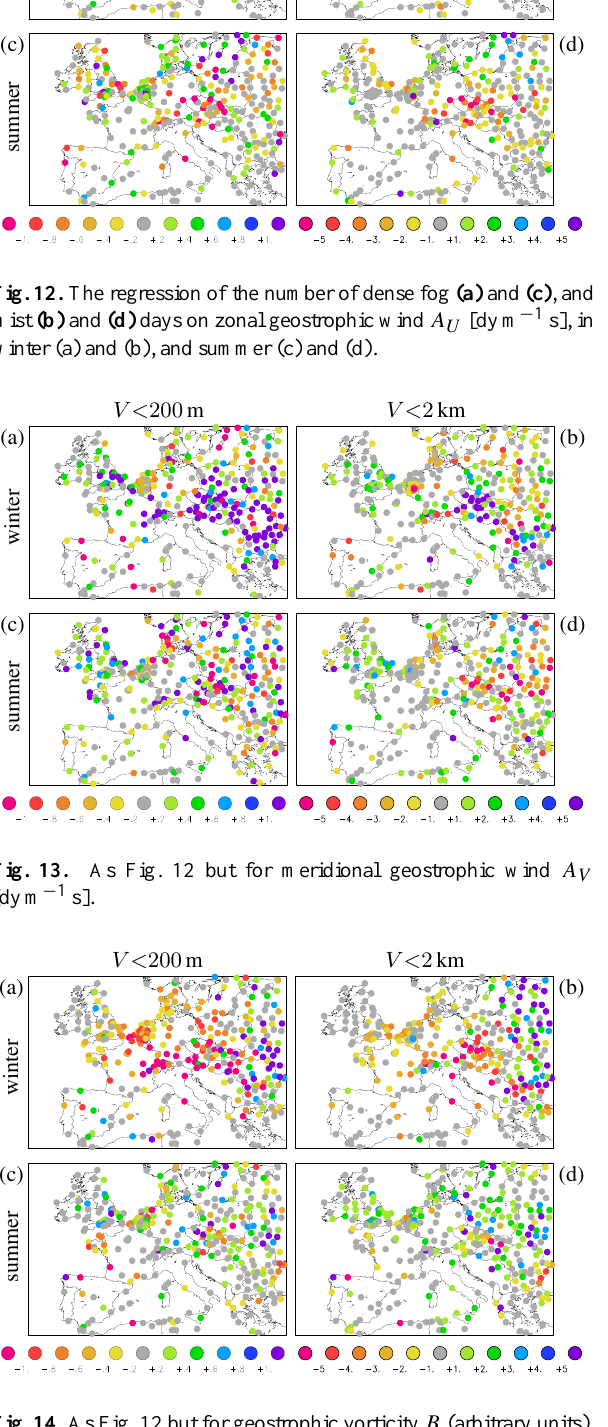
Fig. 14. As Fig. 12 but for geostrophic vorticity B (arbitrary units). parently different mechanisms play a role here for dense fog and mist. In summer the effect of circulation is more dependent on local factors. An example is the east coast of Britain, where the regression is negative: easterly winds tend to advect sea fog to the land (Fig. 12). At the other side of the North Sea the sign is opposite. North of the Alps and in eastern Europe, years with anomalously southerly winds have on average more fog and mist days. Finally, the regression on vorticity (Fig. 14) shows that the opposition between summer and winter noted for De Bilt holds for a large part of Europe. In winter, a season with more negative vorticity (high pressure) gives rise to more fog days, due to more pollution and/or colder nights. In Russia and Ukraine, the relationship is the opposite. This effect is